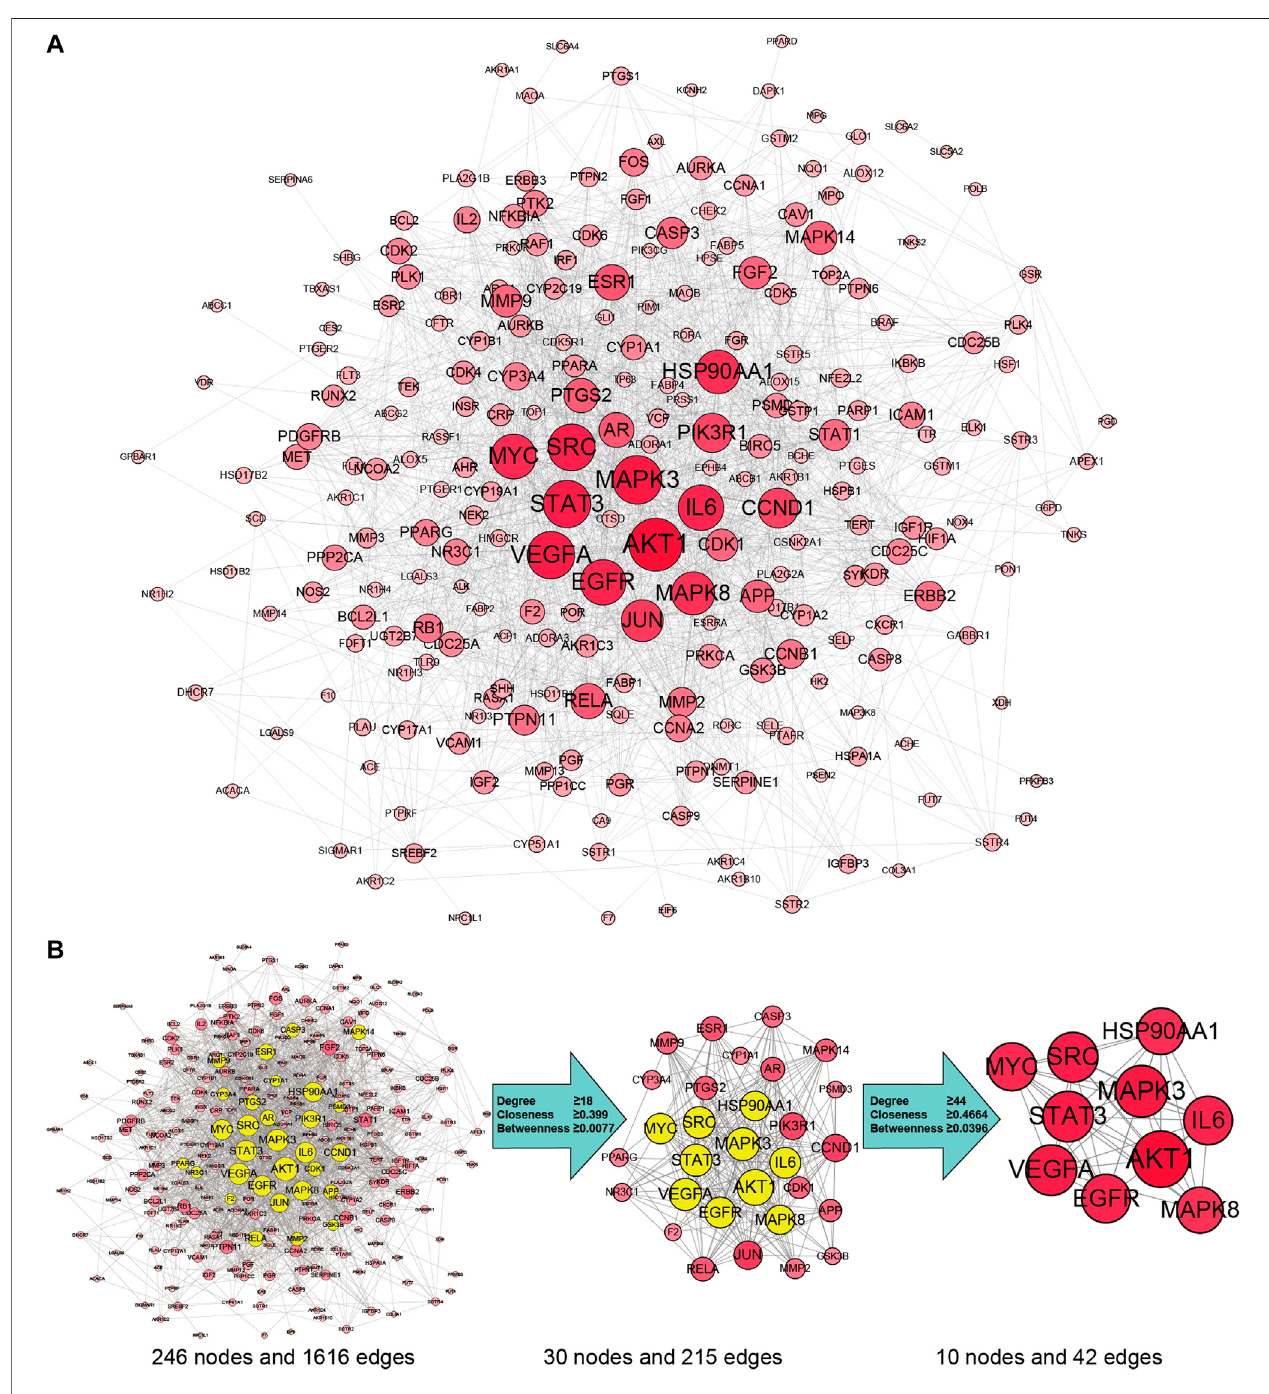
FIGURE 4 | SO targets — HCC PPI network. (A) The network contains 246 gene nodes and 1,616 edges. Pink circle represents gene targets. The red nodes have higher degrees. Node size of gene targets is proportional to the number of degrees. (B) The process of hub network topological screening.